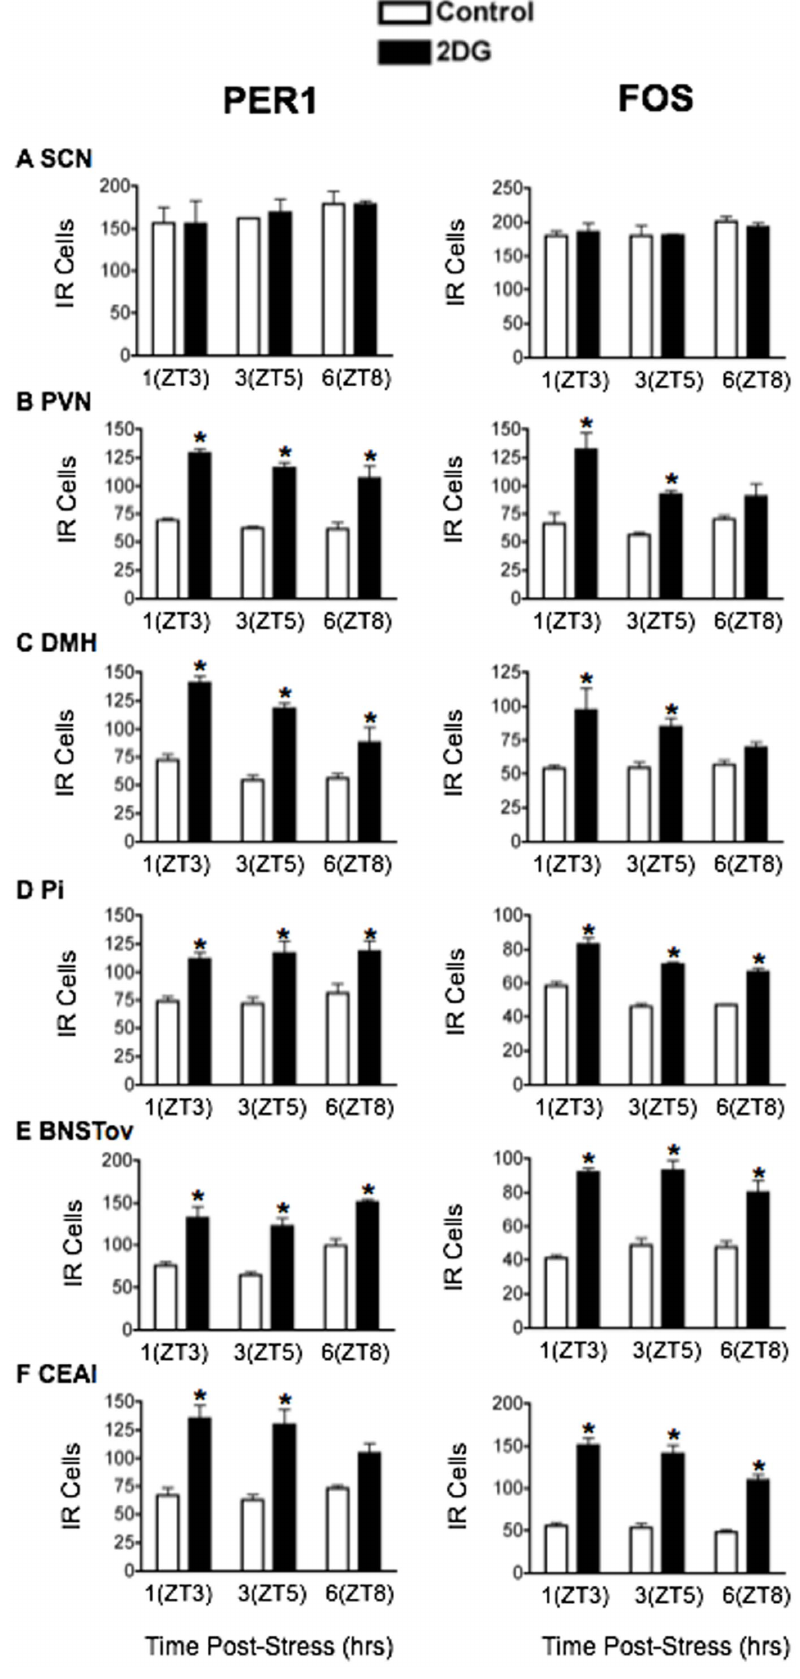
Figure 6. The effect of acute 2DG (250 mg/kg) treatment on PER1 and FOS expression. Means 6 SEM of immunoreactive (IR) cells are shown, n =4 per group; * significant difference from corresponding control group, p , 0.05. doi:10.1371/journal.pone.0111166.g006 PLOS ONE |